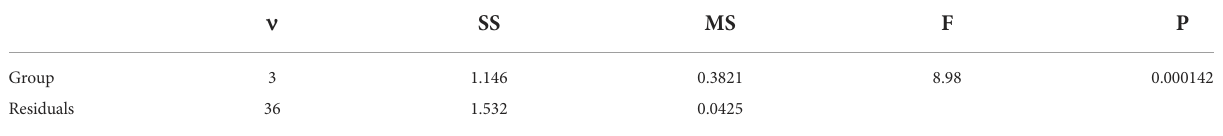
TABLE 5 Results of ANOVA of spleen index.